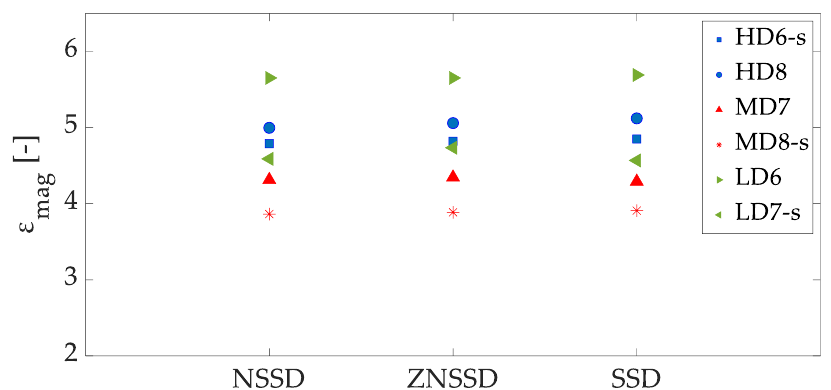
Figure 12. Representation of strain magnification at the apparent ultimate point as a function of the pattern matching criterion. Maximum differences of 3.5% were found between criterion. The extension -s denotes speckled specimens.